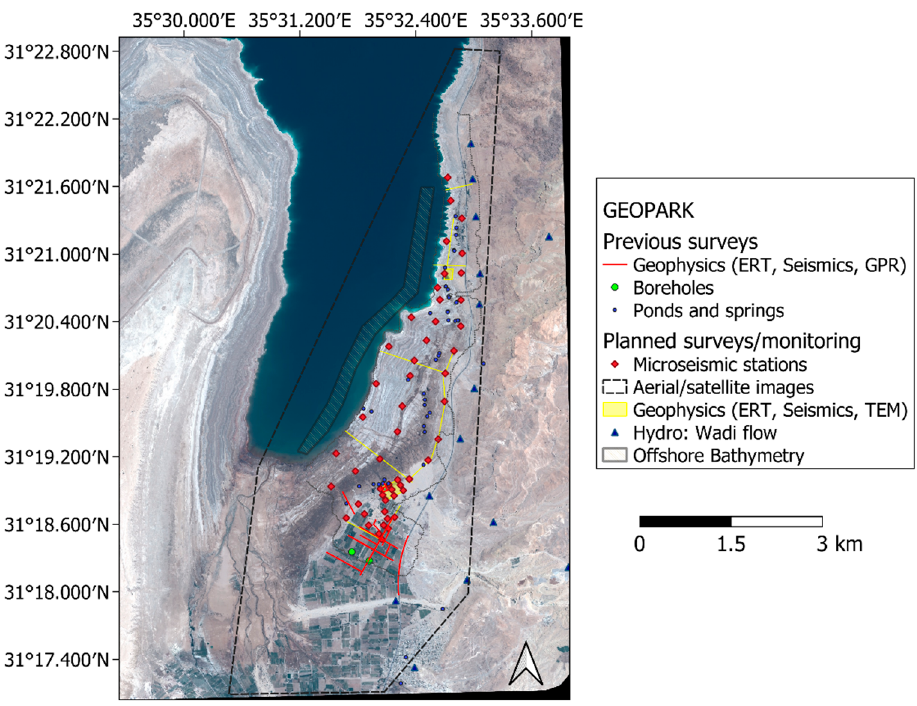
Figure 12. Details of planned hydrogeophysical investigation and monitoring at the field site of Ghor Al ‐ Haditha at the eastern DS, Jordan.